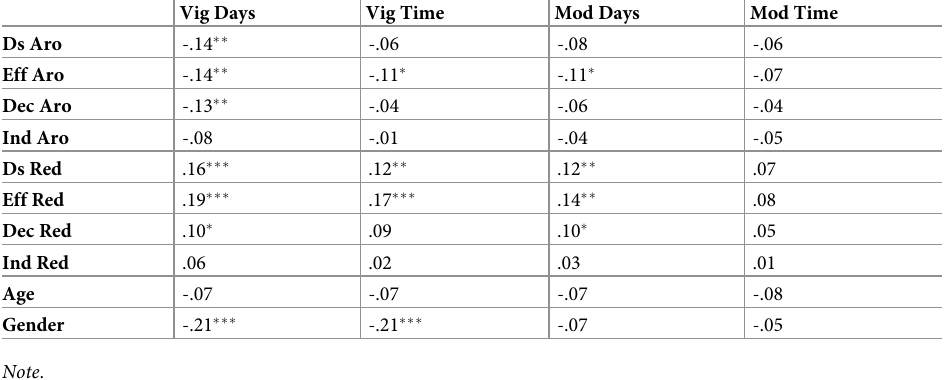
Table 13. Correlations of exercise variables with dissonance-related variables, age, and gender (Study